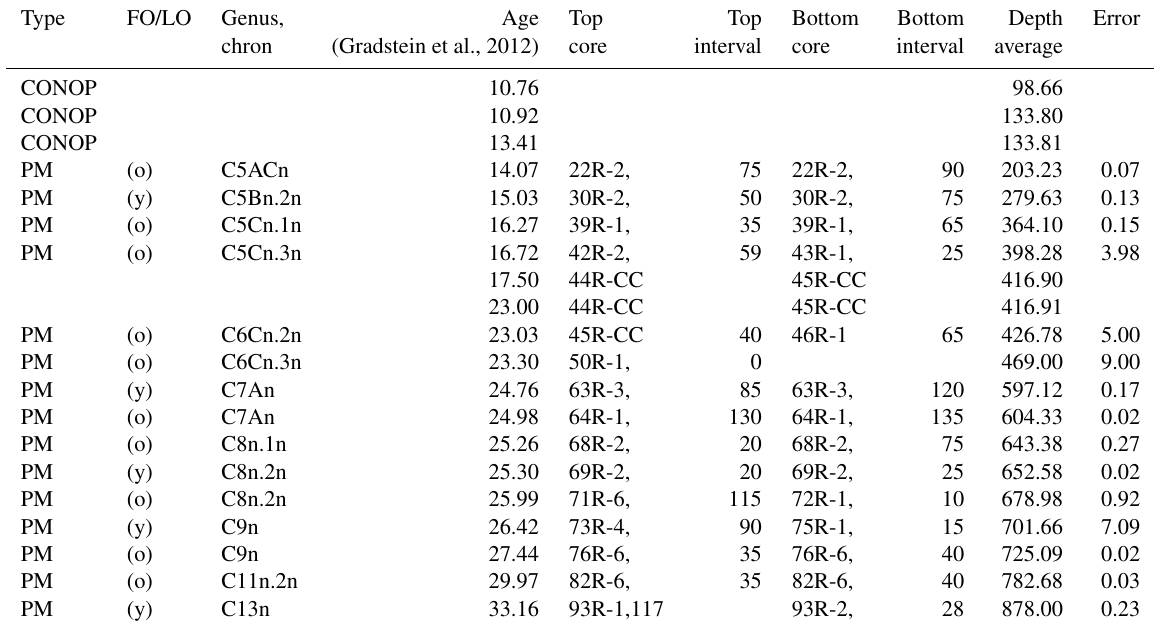
Table 1. Age constraints for the Oligocene–Miocene of Hole U1356A. Type FO/LO Genus, Age Top Top Bottom Bottom Depth Error chron (Gradstein et al., 2012) core interval core interval